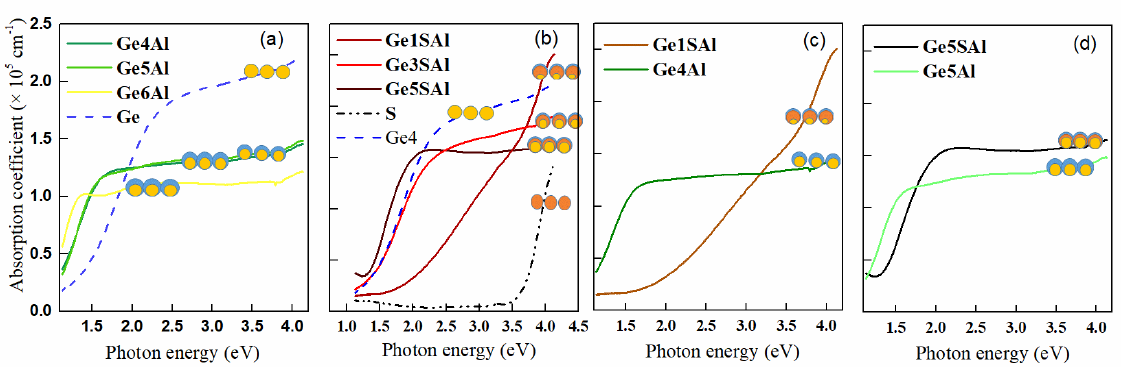
Figure 3. ( a , b ) Absorption coefficient as a function of the photon energy. Comparison of absorption coefficients of ( c ) Ge4Al and Ge4SAl films, and ( d ) of Ge5Al and Ge5SAl, differing only by the Si 3 N 4 shell. The symbols show schematic images of different QD structures that appear in the investigated films.